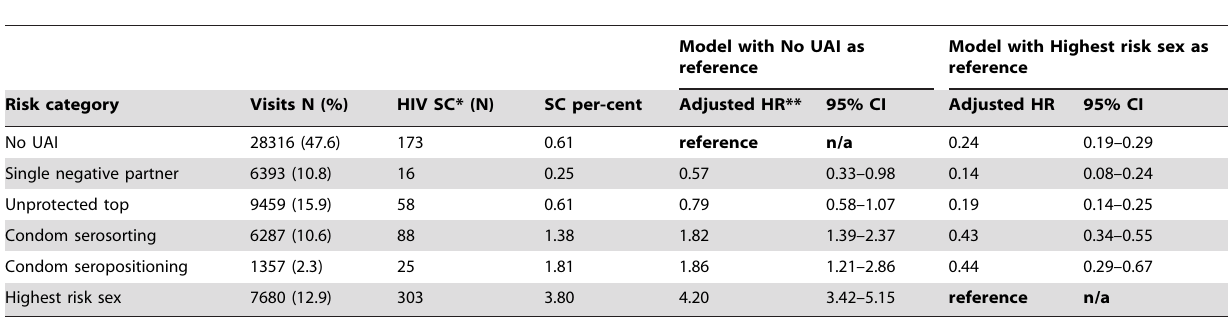
Table 3. Adjusted relative hazards of HIV seroconversion (with condoms) among North American men who have sex with men from four longitudinal cohort studies,